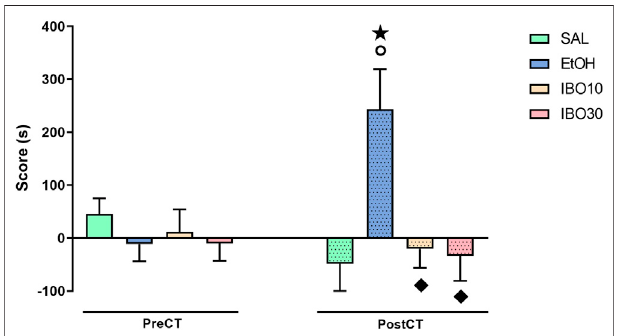
FIGURE3 | Effects ofconditioning withsaline (SAL,i. p.), ethanol (EtOH, 1.8 g/kg, i. p.) or ibogaine (IBO, 10 or 30 mg/kg, oral administration) in the conditioned place preference (CPP) paradigm. Total distance traveled in the CPP apparatus during the pre-conditioningtest (preCT, n (cid:2) 8per group) and the post-conditioning test (postCT, n (cid:2) 8 per group) sessions. Data are reported as means ±